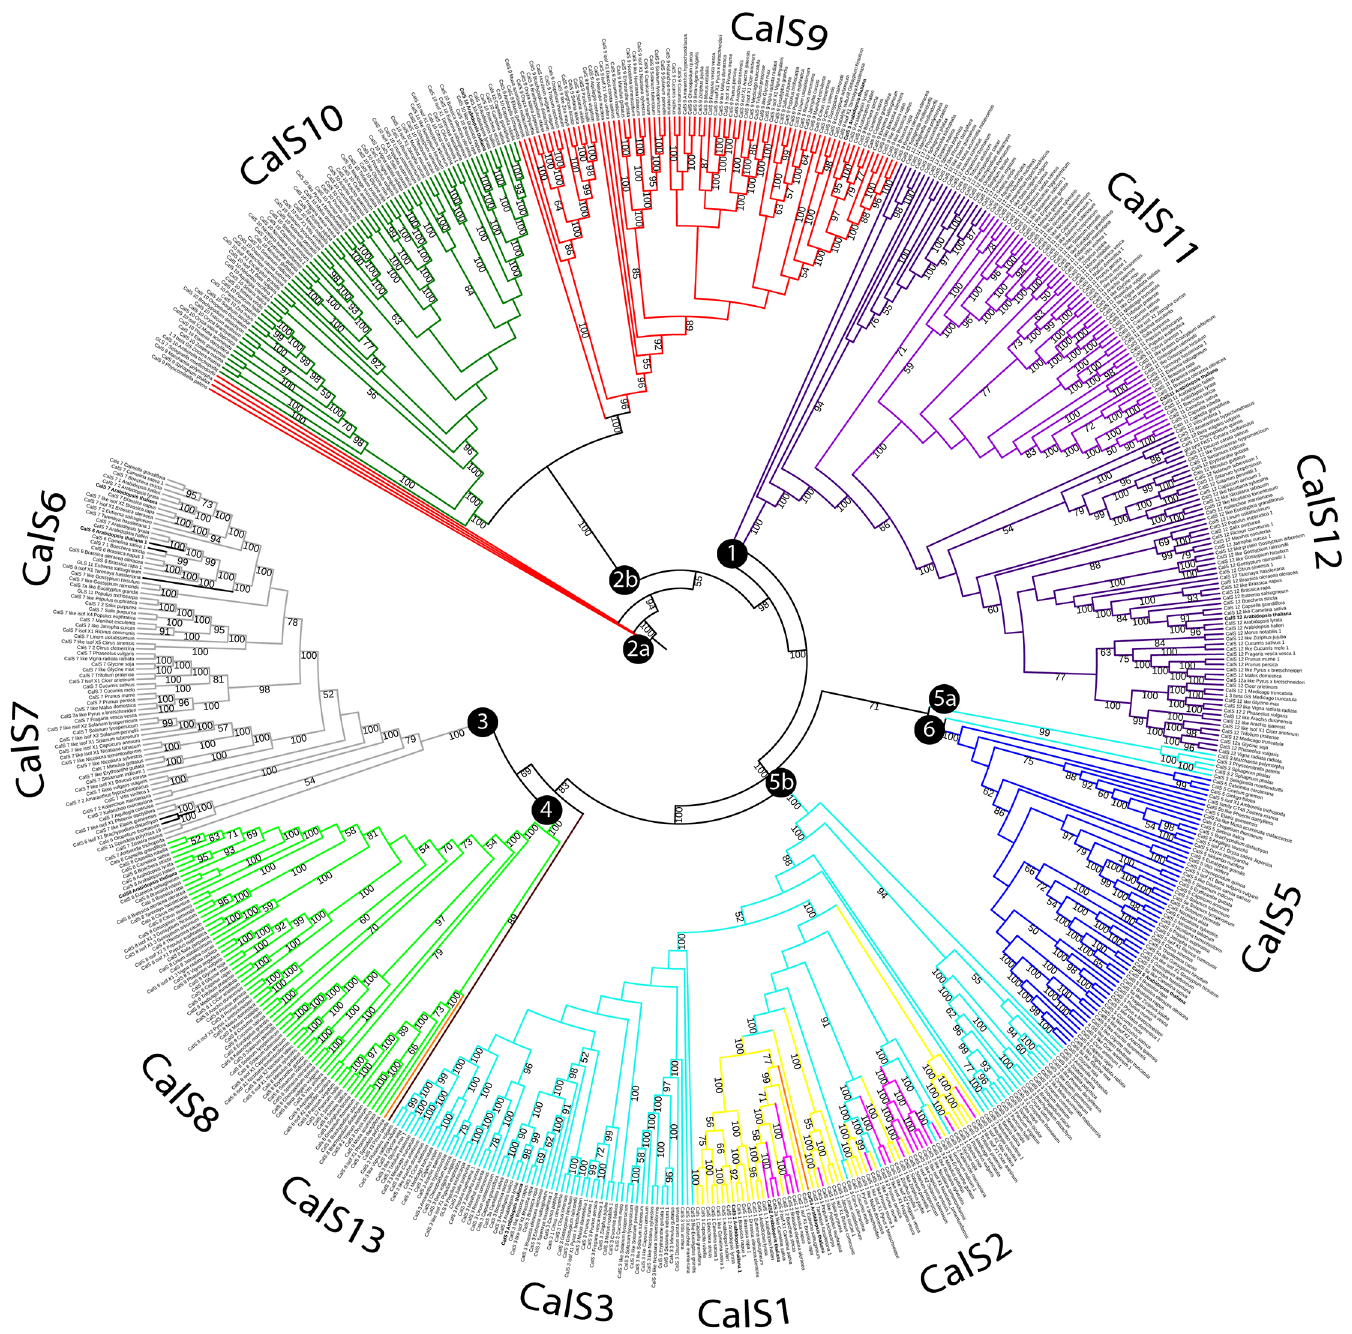
Fig 5. Unrooted phylogenetic tree of 655 proteins sequences of the callose synthase. The evolutionary history was inferred using maximum likelihood.Bootstrap support values (cid:21) 50% are shown on the branchabove. The ML log likelihood-482640.553247. The analysisincluded655 amino acid sequencesand 3435positions in the final data set. Numbers in circles indicate main clades describedin the text. (orders, S2–S6 Figs). Branch lengths indicated the length of time between nodes on a relative timescale. Relative time within each branch did not differ substantially, indicating a common origin and higher conservation in the callose synthase proteins. Only the relative times for